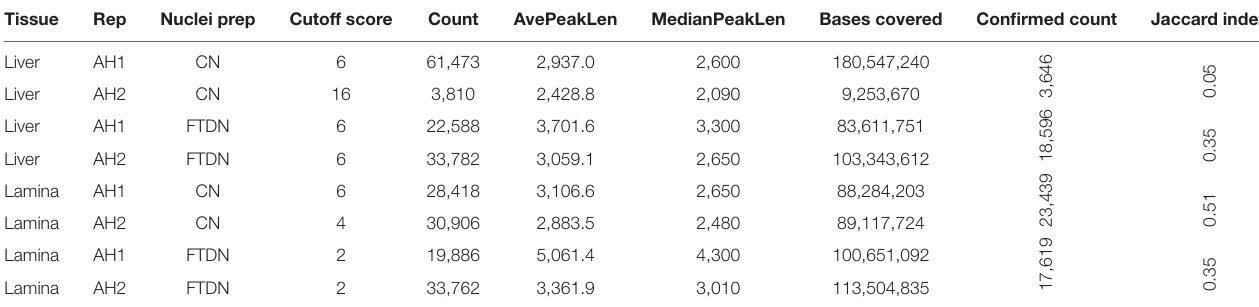
TABLE 1 | Cutoff used to filter peaks and metrics of filtered